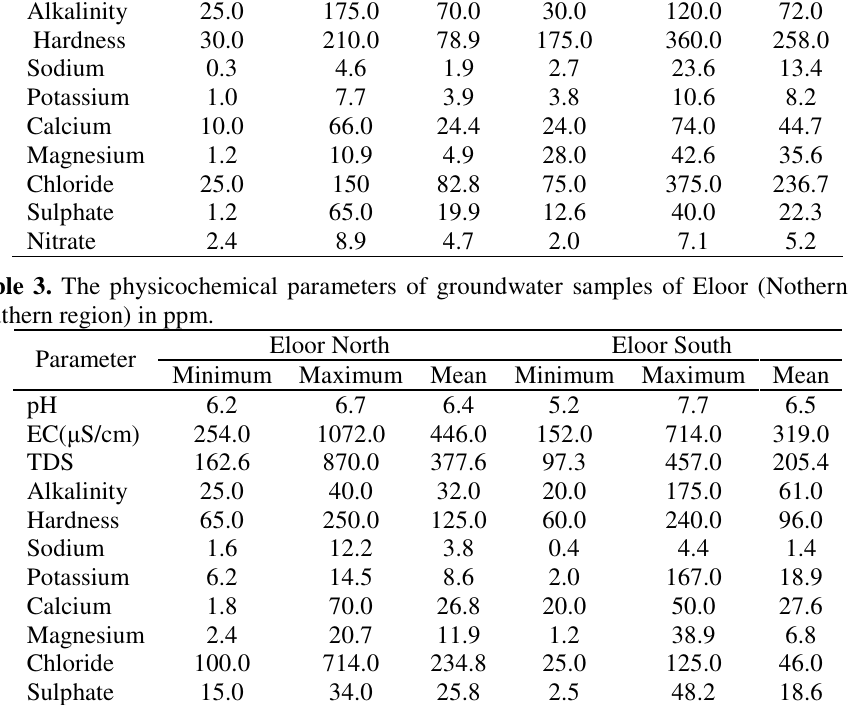
Electrical Conductivity (EC) varies between 95 to 1072 µ mho/cm and significantly high in few samples from the western and northern region indicating the presence of ionic contaminants (Figure